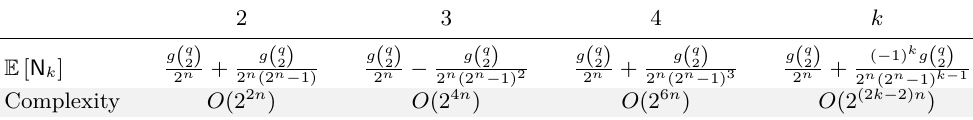
Table 2: Expected numbers of collisions E [ N k ] after q queries for the sums of k permutations and distinguishing complexity for q ’ 2 n from